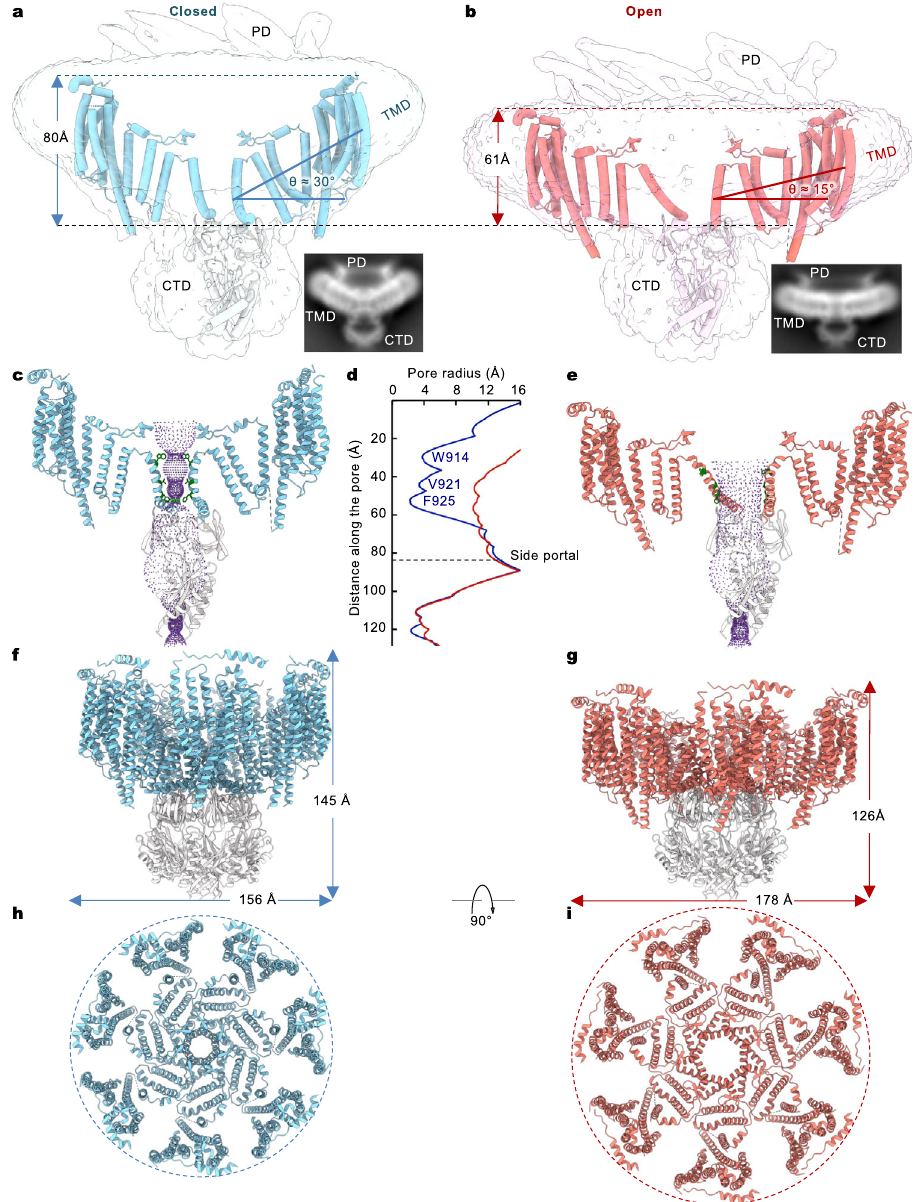
Fig. 3 | Opening of Ec MscK. a , b Closed ( a ) and open ( b ) structures of Ec MscK G924S. Only two opposing subunits are shown for clarity. The surfaces of the unsharpened maps indicate the positions of the PD, TMD, and CTD. Dotted lines indicate the cytoplasmic and periplasmic boundaries. Insets are 2D class averages